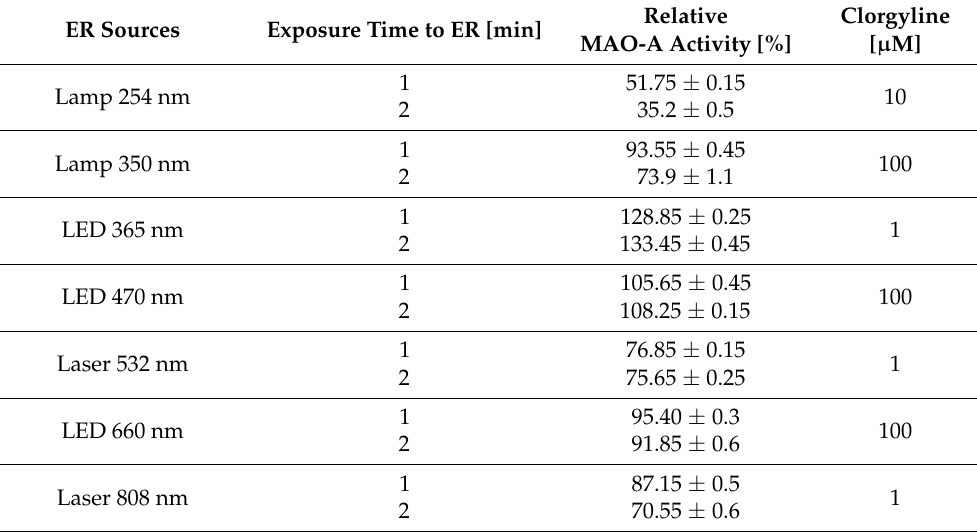
Table 3. Relative MAO-A enzymatic activity after irradiation with lasers, lamps and LEDs. ER Sources Exposure Time to ER [min]